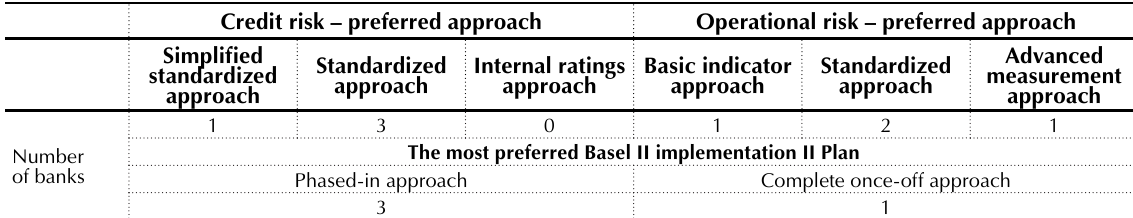
Table 3. Pillar 1: credit risk and operational